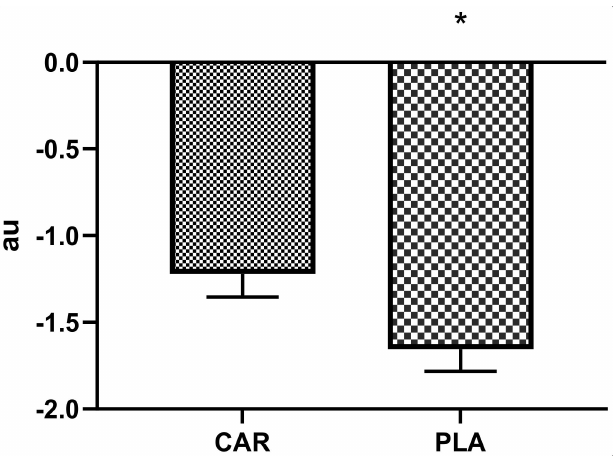
Figure 3. Relative perceived recovery status. Mean values and error bars for the standard error of the mean for perceived recovery values normalized to training volume for the muscle damaging protocol are shown. The following equation was deployed to reach the arbitrary units (au): (Post Exercise PRS - True Baseline Pre)/total repetitions) × 100; * indicates a significant difference between groups ( p < 0.05). The groups are carnitine (CAR) and placebo (PLA). Abbreviations: au—arbitrary